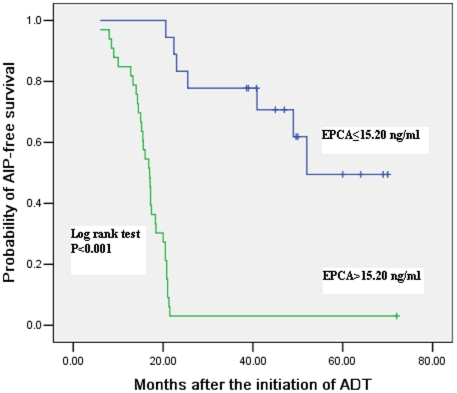
Kaplan-Meier estimates of AIP-free survival probability for the 51 patients with locally advanced and metastatic PCa treated with ADT, who were grouped by the baseline serum EPCA level above or below the median value of 15.20 ng/ml.